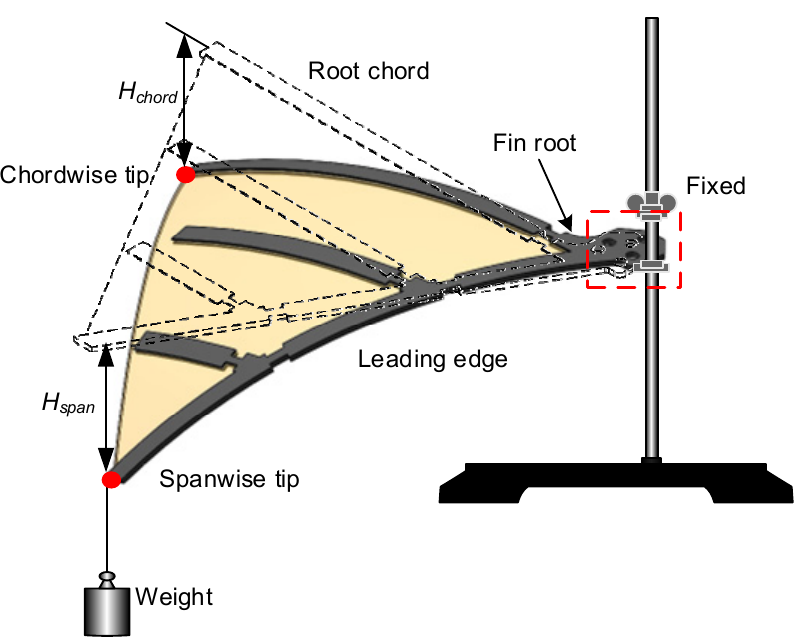
Figure 2. CJF spreadwise and chordwise bending stiffness test.